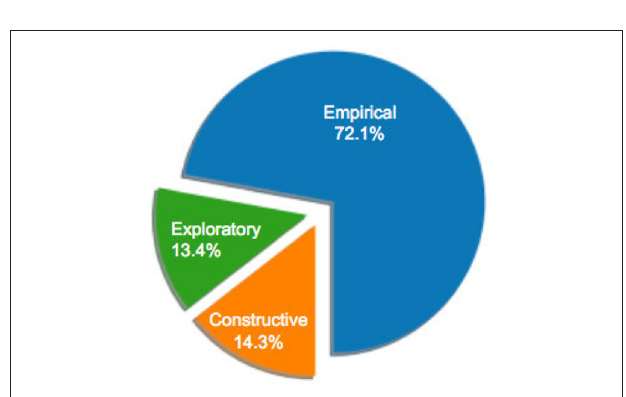
FIGURE 2 | Percentage of sample articles by research type.